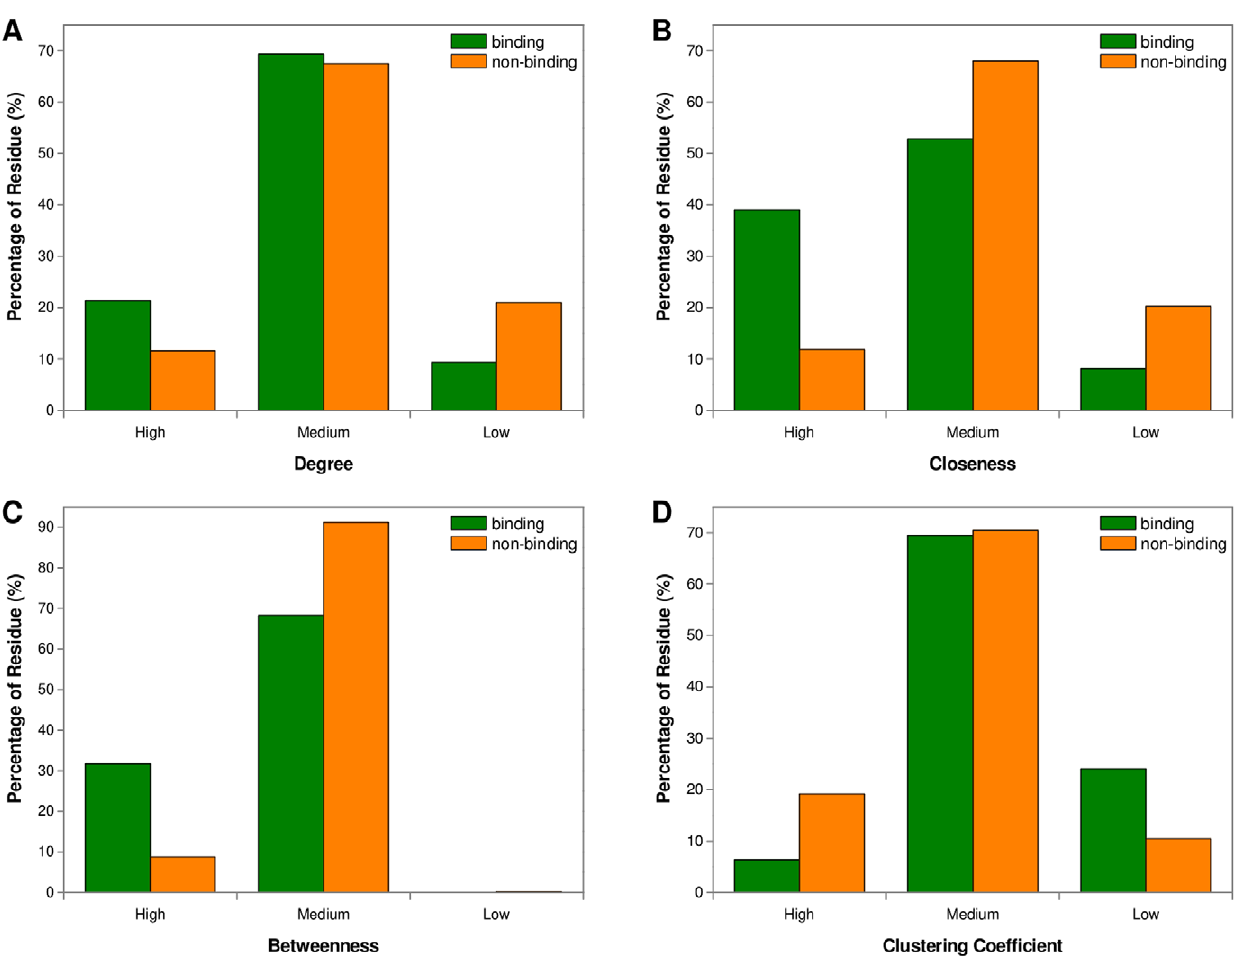
Figure 1. Distribution comparison of network-based features of heme-binding and non-binding residues. (a) Degree; (b) Closeness; (c) Betweenness; (d) Clustering Coefficient. For each topological feature, the z-scores of binding and non-binding residues in Dataset 1 are divided into high, medium and low score sections, and then the fraction occupied by each section was calculated. doi:10.1371/journal.pone.0025560.g001 PLoS ONE |